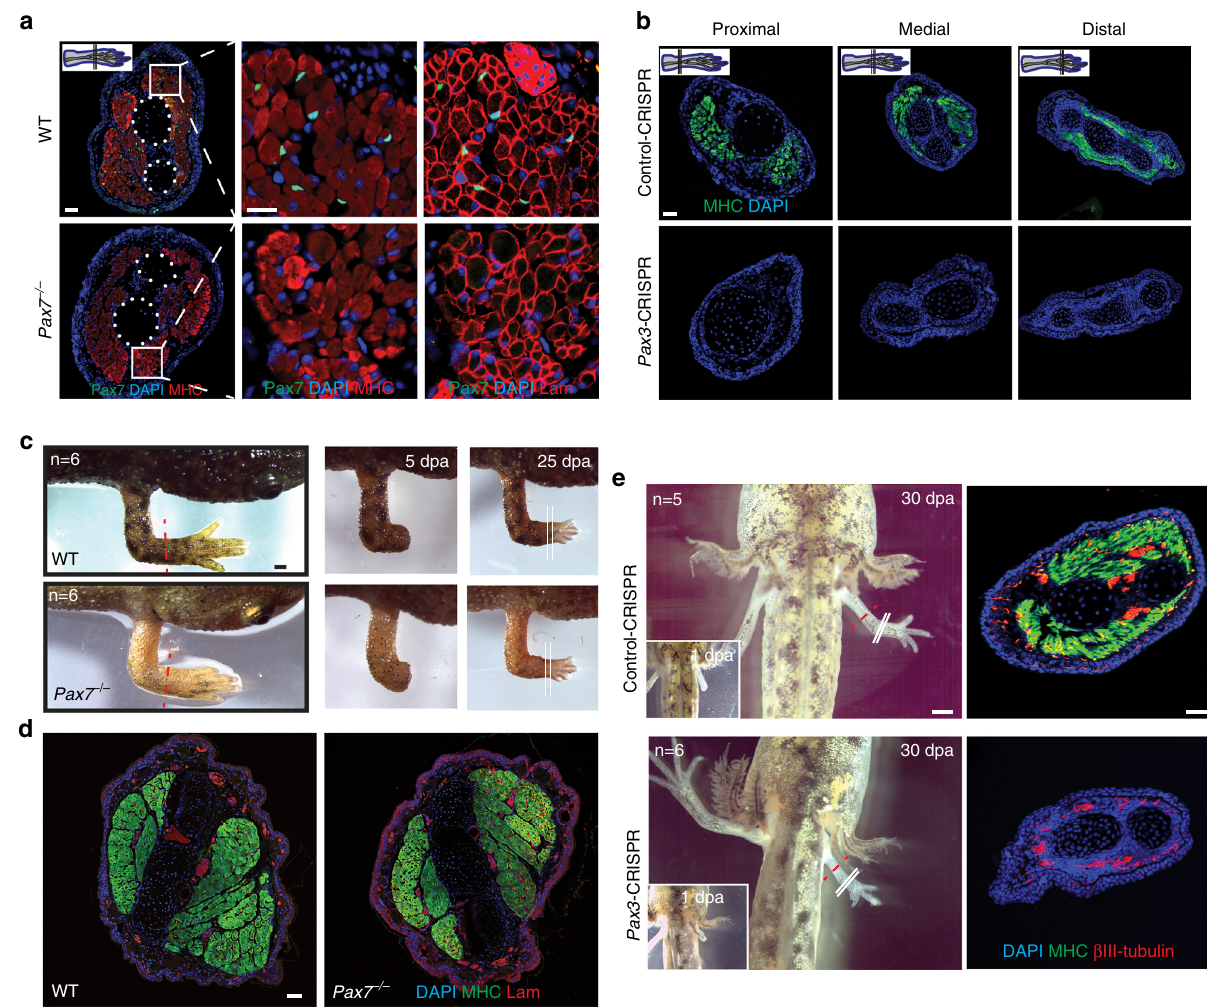
Fig. 3 Newt limb muscle development and regeneration is independent of Pax7 . a Pax7 − / − F 1 P . waltl have normal limb skeletal muscle. Note the similar myosin heavy chain (MHC) and laminin (Lam) staining in Pax7 − / − and WT animals. Scale bars = 200 µ m in the overview and 20 µ m in the insert. b Pax3 - CRISPR mosaic animals have muscle-less limbs. Immuno fl uorescent staining for MHC in transverse sections of Pax3 -CRISPR and control-CRISPR limbs. Scale bar = 100 µ m. c Limb regeneration is not impaired in post-metamorphic Pax7 − / − F 1 animals. Scale bar = 1 mm. d Pax7 − / − F 1 animals regenerate normal skeletal muscle in the new limb. Note the indistinguishable myosin heavy chain (MHC) and laminin staining in Pax7 − / − and WT animals. Scale bar = 100 µ m. e muscle-less limbs in Pax3 -CRISPR mosaic animals (stage 45) regenerate muscle-less limbs. Immuno fl uorescent staining for MHC and the neuronal marker β III-tubulin in transverse sections. Scale bar = 1 mm in the left panels showing animals and 100 µ m in the right panels showing sections. Red dotted lines indicate amputation plane. White lines indicate section